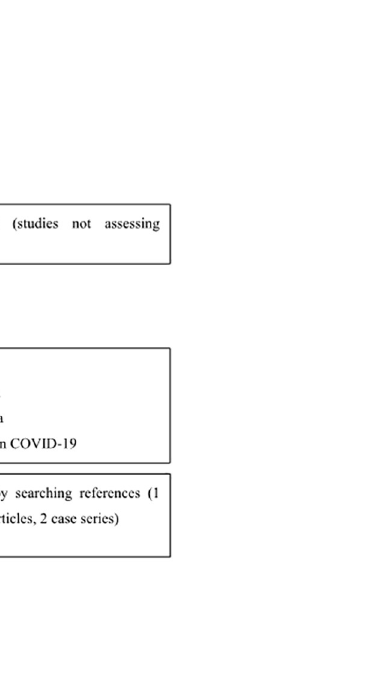
Fig 1. PRISMA flow